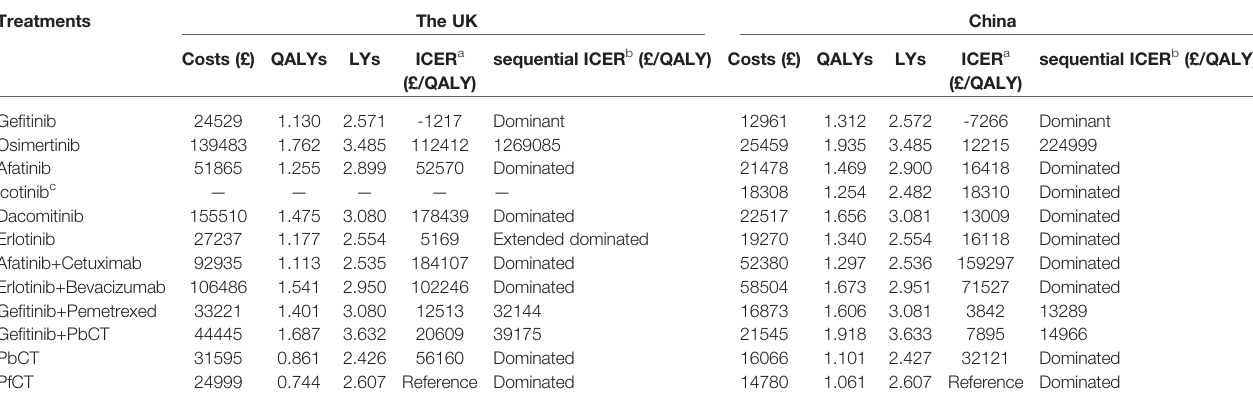
TABLE 3 | Base case results of cost-effectiveness for 12 fi rst-line treatments in the UK and China. Treatments The